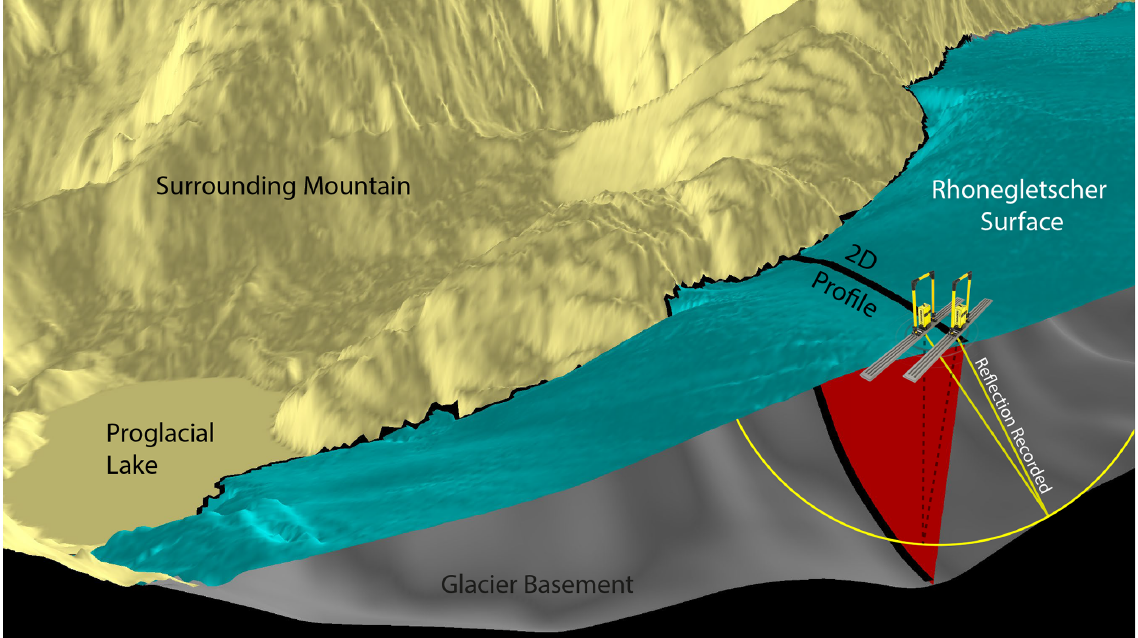
Figure 6. Lower portion of Rhonegletscher showing an example acquired GPR data point. The GPR antennas are located on the surface, and the yellow lines represent the shortest ray path for a reflection from the glacier basement. The dashed black ray path represents the basement imaging point when performing 2D GPR processing. This ray path does not correspond to the true basement position but the out-of-plane basement reflection point. This type of ray path is known as an off-nadir reflection.